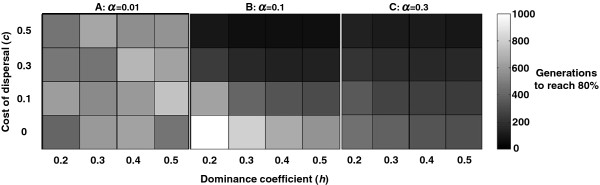
Invasion of Fitness-Associated Dispersal. FAD invaded a population with a uniform dispersal rate throughout the parameter range tested (p ≤ 10-10 for each parameter set, exact binomial test), even though the average dispersal rate of the FAD and uniform subpopulations was held equal in each simulation (αF = αU). The figure shows the mean number of generations required for a FAD allele to increase in frequency from 0.01 to 0.8 in the cases where FAD took over the population (cells’ clarity increases with number of generations), for different values of the mean dispersal rate α (A: α = 0.01, B: α = 0.1, C: α = 0.3). As the cost of dispersal increases the relative advantage of fit FAD individuals that rarely disperse increases and it takes FAD less time to spread. As the average rate of dispersal increases (from panel A to C), FAD takeover occurs more rapidly when the dispersal cost is high, and more slowly when it is low. The effect of the dominance coefficient h was notable mostly at high dispersal rates together with low dispersal cost, where the number of heterozygotes was highest. Parameters: N ≥ 900 for α = 0.01; N ≥ 100 for all other values of α.